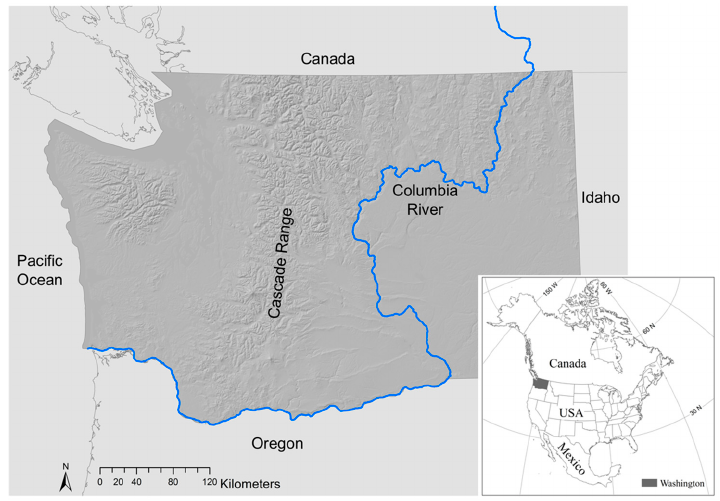
Figure 1 . Location map of the state of Washington, USA. Figure 1. Location map of the state of Washington,